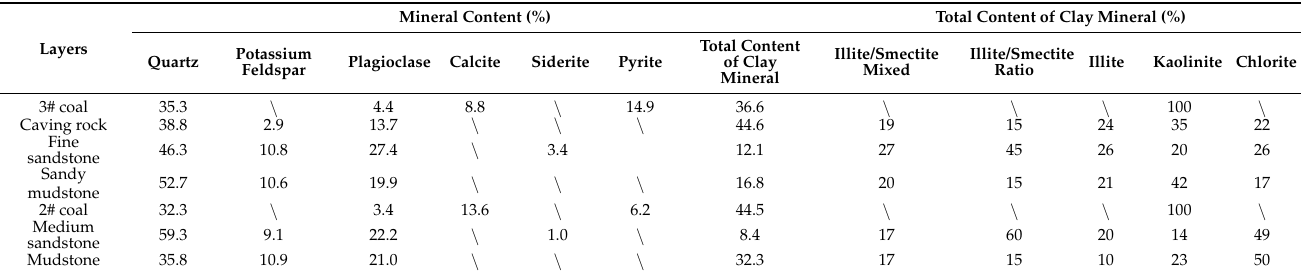
Table 2. Mineral content of rock layers.